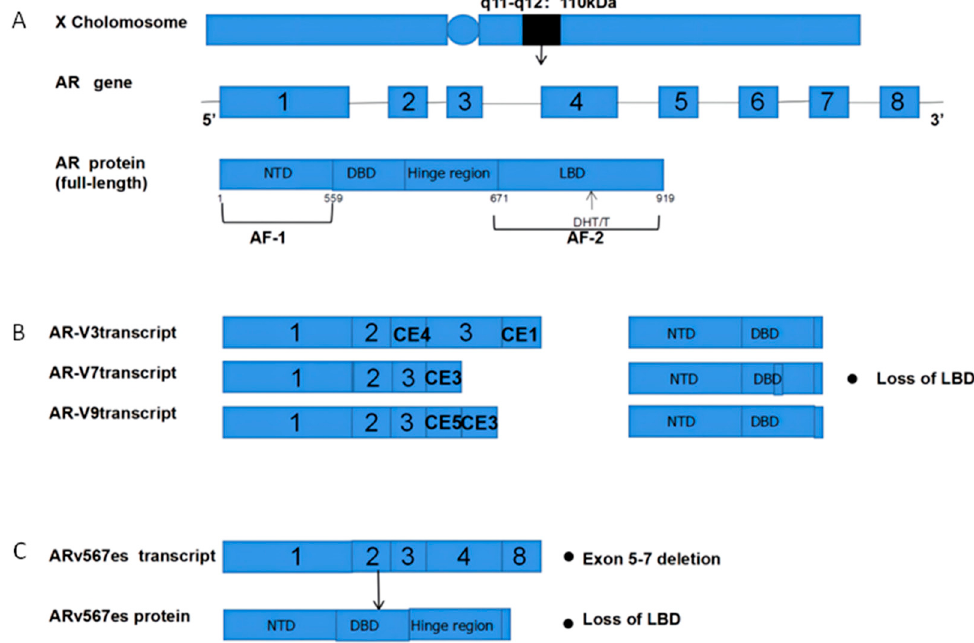
Figure 1. Structural overview of ARs and AR-Vs (AR-V3,7,9 and ARv567es). ( A ) Structural overview of the AR gene, located on the X chromosome q11-q12, encoding 919 amino acids and consisting of eight exons. The DHT and T ligands to the AR LBD; ( B ) The mechanisms underlying AR-V3, AR-V7, and AR-V9 production. Exons 4–8 are sheared to produce truncated AR-Vs that lack a LBD and Hinge region; ( C ) Mechanisms governing the production of ARv567es. Exons 5–7 are missing, resulting in truncated AR proteins and the lack of a LBD. AR = Androgen receptor; AR-Vs = AR variants; NTD = N-terminal transcriptional domain; DBD = DNA-binding domain; LBD = C-terminal ligand-binding domain; CE5 = cryptic exon 5; CE3 = cryptic exon 3; PAS = polyadenylation site; CE4 = cryptic exon.